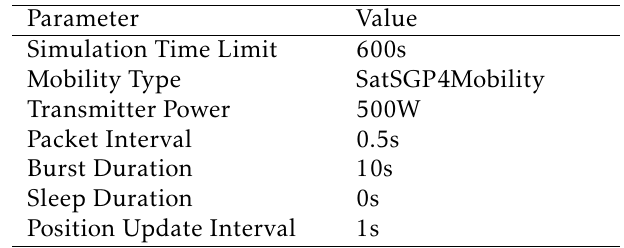
Table 2. Default satellite parameters